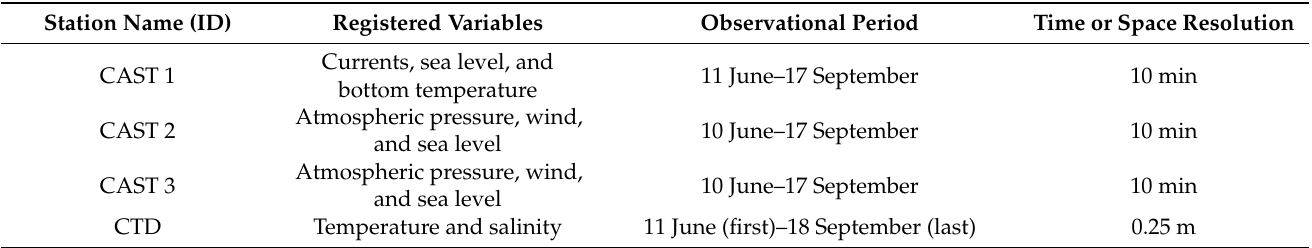
Table 4. Summary of measured data at the stations, shown in Figure 1, corresponding to the Castell ó n harbour campaigns, indicating observation periods and data recording